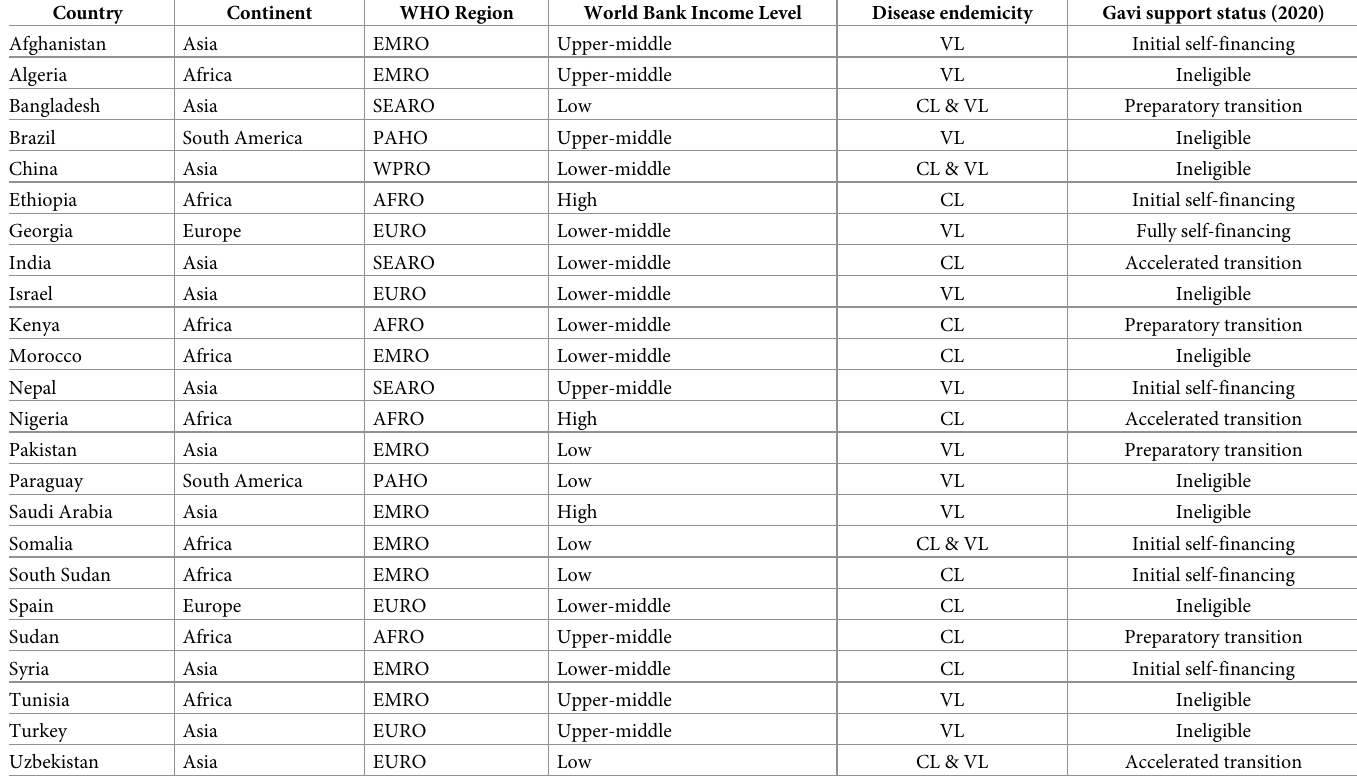
Table 1. List of countries included in the